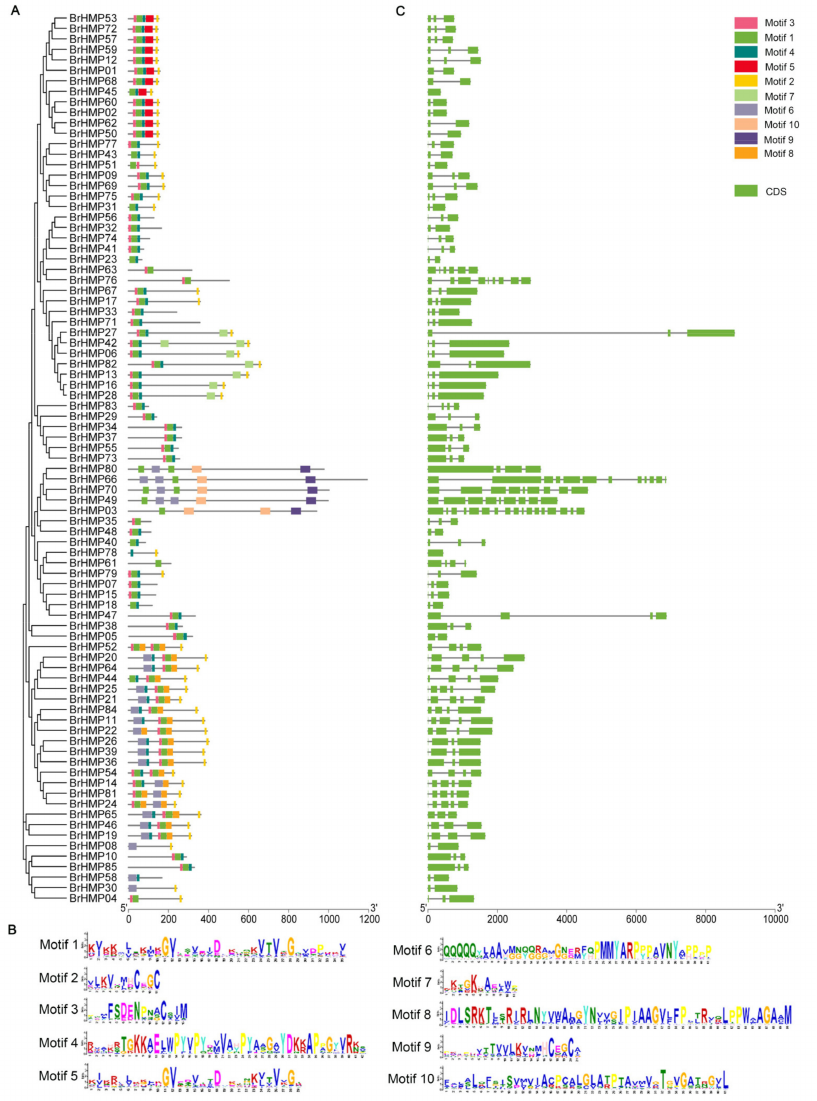
Figure 4. Gene structure and conserved motifs of BrHMPs. ( A ) Composition and distribution of conserved motifs. ( B ) Exon–intron structure of BrHMPs. Green boxes are exons, and lines connecting exons and introns are introns. ( C ) Ten conserved motif sequences of